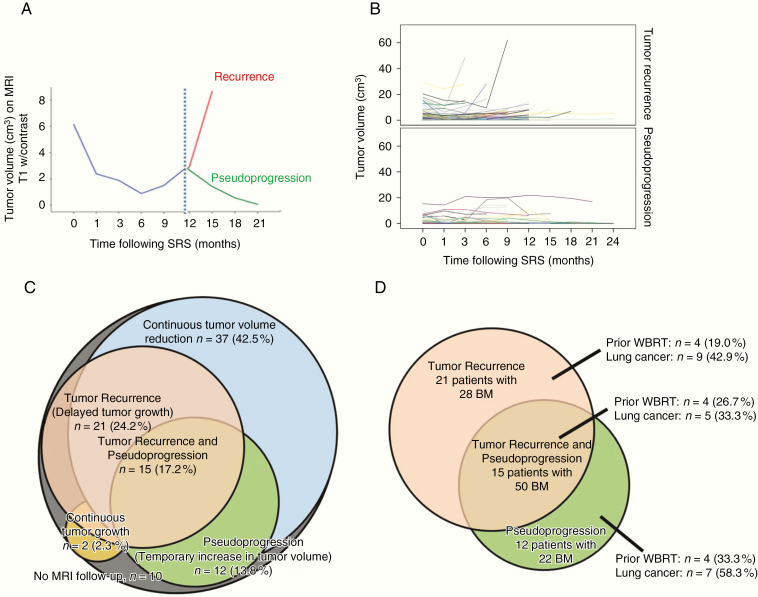
(A) Illustration of 2 potential response patterns for brain metastases (BM) treated with stereotactic radiosurgery (SRS): pseudoprogression (PP) and tumor recurrence (TR). (B) Individual tumor volume response curves on contrast enhanced T1-weighted MRI at stereotactic radiosurgery (time: 0) and during follow-up for (A) 53 pseudoprogressing tumors and (B) 47 recurring tumors. (C) Venn diagram of 87 out of 97 patients with follow-up MRI of a total of 348 BM post-radiosurgery. The diagram illustrates the proportion of patients with BM responding with the 4 distinct volumetric response patterns on contrast enhanced MRI: tumor recurrence (red), pseudoprogression (green), continuous tumor volume reduction (blue), and continuous tumor growth (orange). (D) Venn diagram of patients (n = 48) included in the development of the Bergen Criteria. Tumor type (lung cancer vs. other primary sites) and prior irradiation history for patients in 3 cohorts are illustrated: 21 (43.8%) patients with 28 recurrences (red), 12 (25.0%) patients with 22 pseudoprogressions (green), and 15 (31.2%) patients with some recurrences (n = 25 BM) and some pseudoprogressions (n = 25 BM) following initial and/or repeat-SRS. MRI, magnetic resonance imaging.